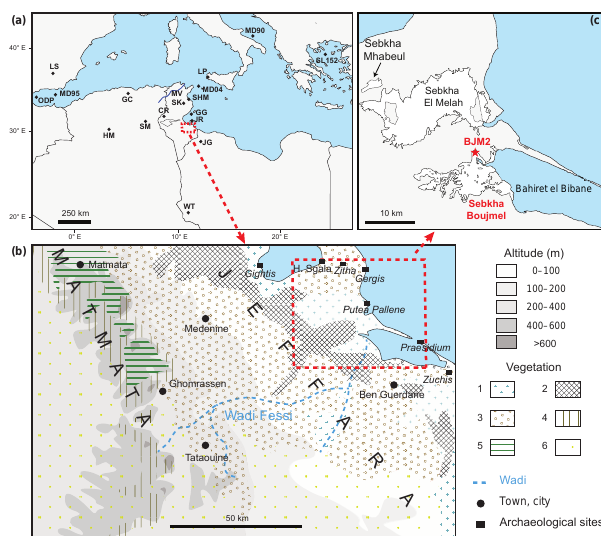
Figure 1. Geographical settings. (a) Large map of the Mediter- ranean Basin showing the location of the study area (outlined in red in map b and shown in detail in c ) and of selected Mediter- ranean records referred to in the text. CR: Chott Rharsa; GC: Guel- daman Cave; GG: Golfe de Gabès; HM: Hassi el Mejnah; JG: Jbel Gharbi; JR: Île de Jerba; LP: Lake Preola; LS: Lake Siles; MD04: core MD 04-2797; MD90: core MD 90-917; MD95: core MD 95- 2043; MV: Medjerda Valley; ODP: ODP site 976; SHM: Sebkha Halk el Menjel; SK: Sebkha Kalbiyya; SM: Sebkha Mellala; WT: Wadi Teshuinat. (b) Inset map that shows main regional setting for Sebkha Boujmel including topography, vegetation (after Gam- mar, 2008), hydrographic network, archaeological sites (after Drine, 1993) and current cities. Vegetation 1: halophilous vegetation. 2: gypsophilous steppe with Lygeum and Zygophyllum . 3: cultivated fields ( Olea ) and steppe with Rhanterium , Haloxylon scoparium and Artemisia . 4: steppe with Haloxylon scoparium and Haloxy- lon schimittianum . 5: steppe with Stipa tenacessima and matorral with Juniperus phoenicea . 6: desert vegetation with Helianthemum sp., Calligonum , Gymnocarpos decander and Traganum nudatum . (c) Detailed map displays the location of Sebkha Boujmel, the stud- ied core (BJM2) and other nearby sebkhas mentioned in the